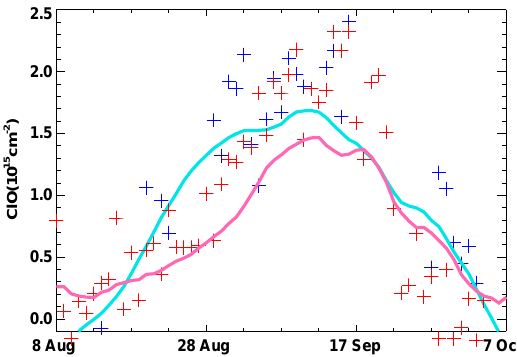
Figure 3. Daily (day minus night) column density of ClO mea- surements at altitudes above 100hPa for mid-August to mid- October 2006 from ChlOE measurements at Scott Base (blue crosses) and from MLS measurements within ± 2 ◦ latitude and ± 15 ◦ longitude of Scott Base (red crosses). Also shown are cli- matologies for this period based on the ChlOE measurements from 1996 to 2015 (light blue line) and MLS measurements from 2004 to 2015 (pink line).